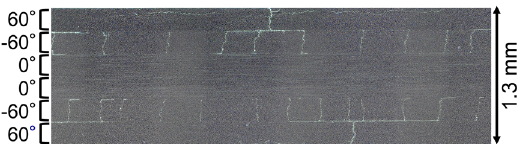
Figure 1. Optical micrograph of cross section in the CFRP laminate subjected to fatigue cycling up to N = 10 6 , as revealed by fluorescent penetrant inspection